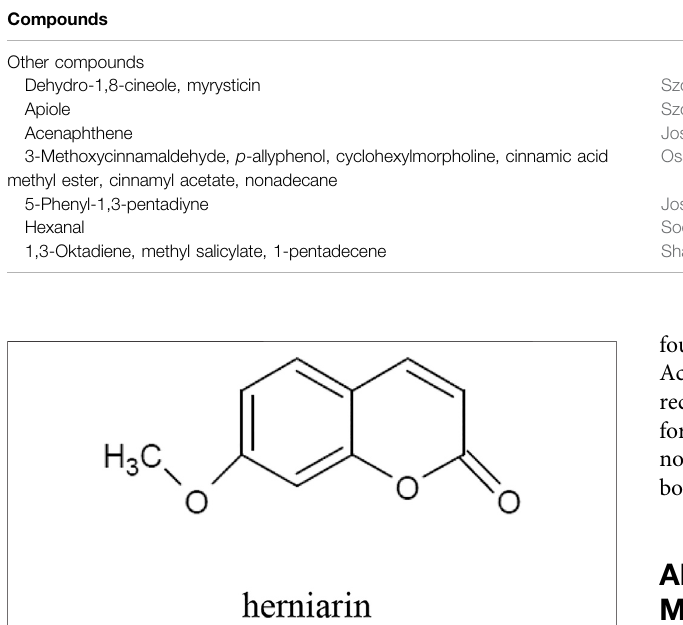
Frontiers in Pharmacology |